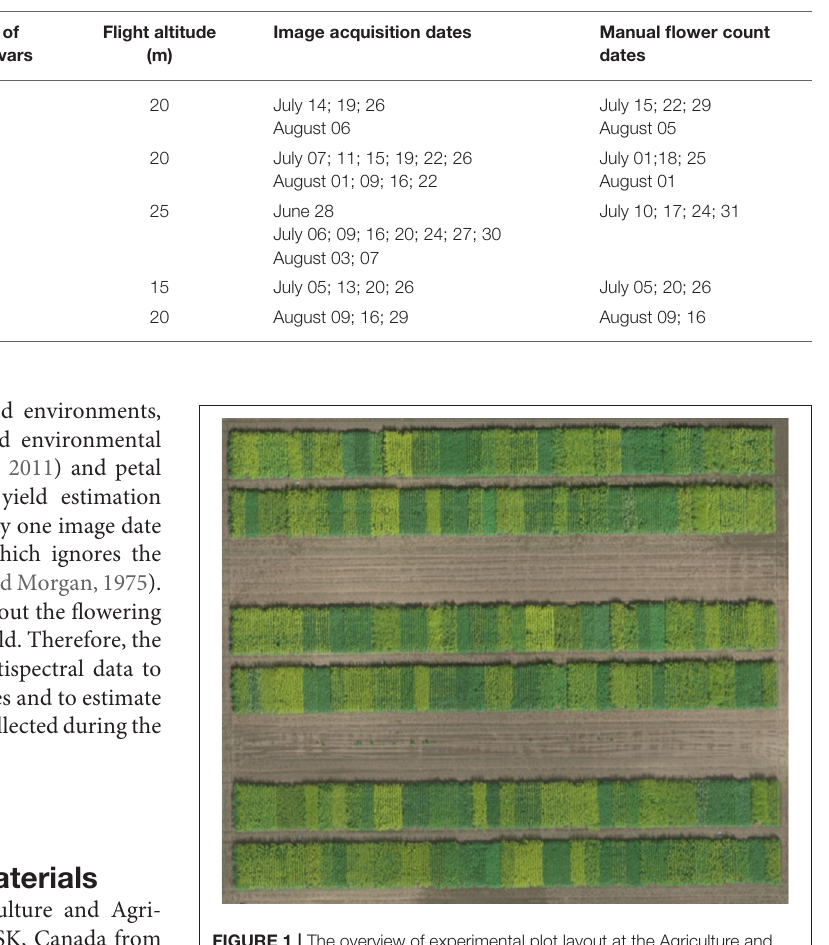
TABLE 1 | Summary of canola trials and data collection (imagery acquisition and manual flower count) at Saskatoon, SK, Canada from 2016 to 2018 and at Melfort and Scott, SK, Canada in 2017.